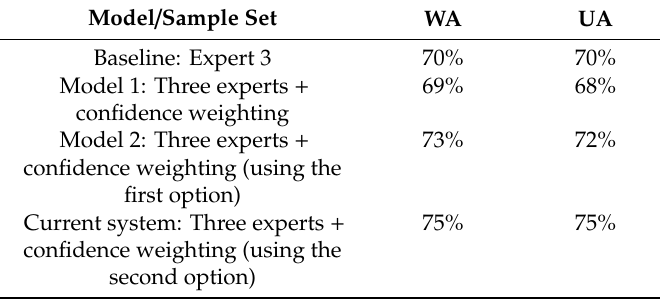
Table 6. Test results of the ensemble